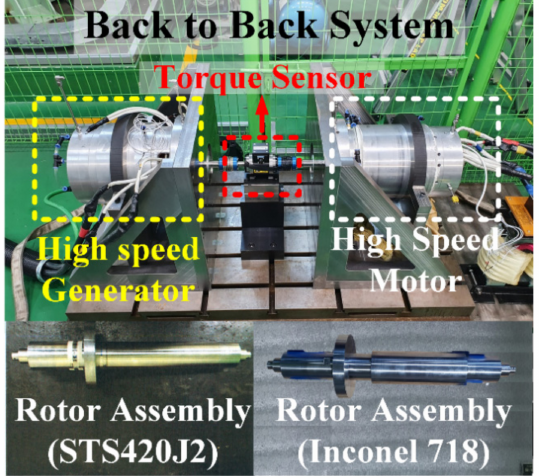
Figure 9. Test bed and rotor assembly of high-speed PMSG.